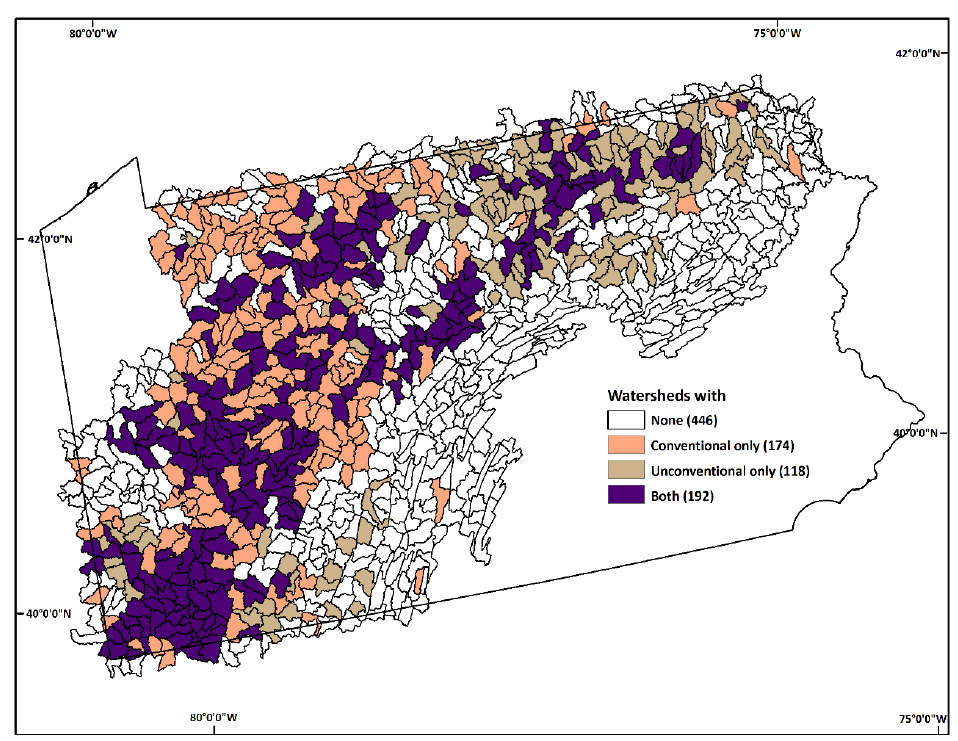
Figure 3. Study area 12-digit hydrologic units (HUC-12) watersheds and the pattern of oil and gas development. Values in parentheses are the number of watersheds.